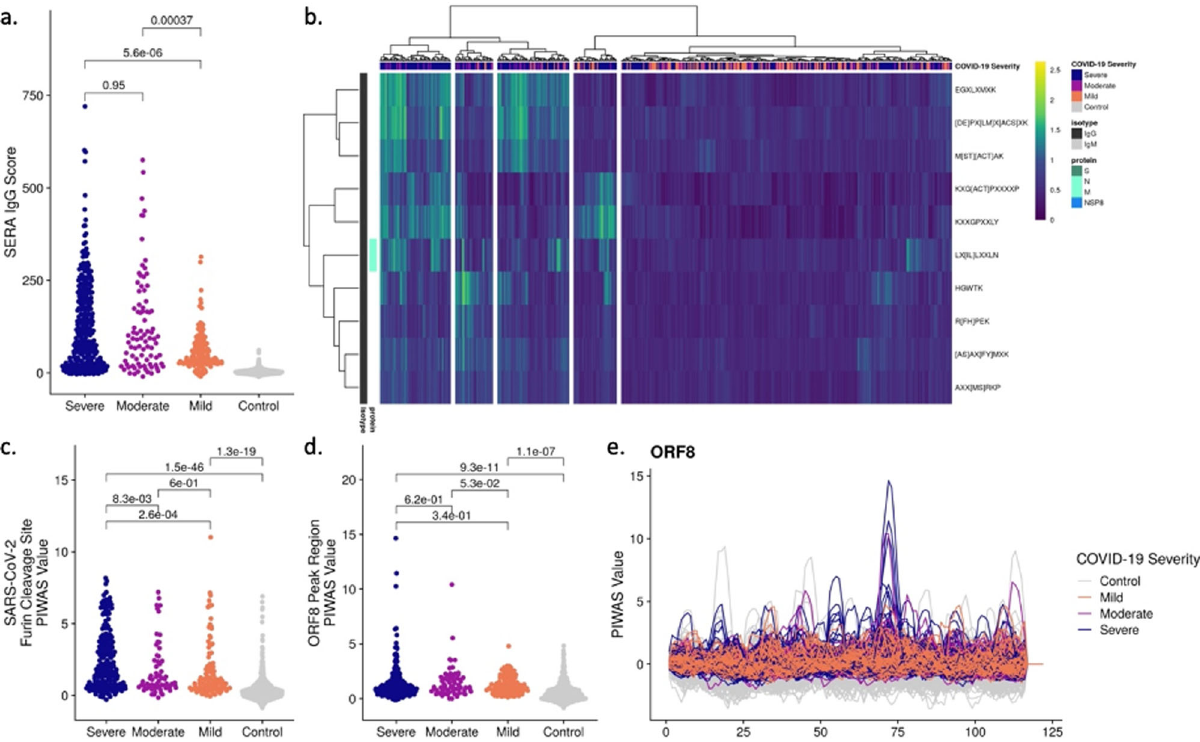
Fig. 4 Signi fi cantly different epitope signals are observed in mild, moderate, and severe cases of COVID-19. a Comparison of SERA total IgG motif panel scores for severe ( n = 447), moderate ( n = 134), and mild ( n = 170) cases based on motifs used in the diagnostic panel (Fig. 3). Colors indicate disease severity. b Severe, moderate, and mild cases of SARS-CoV-2 are clustered based on log-enrichment of the top 10 motifs identi fi ed by a t-test comparison of severe and mild patients. c Distribution of PIWAS values at SARS-CoV-2 furin cleavage site for severe, moderate, and mild cases. d Distribution of PIWAS values for the peak epitope in ORF8 for severe, moderate, and mild cases. e PIWAS tiling of individual samples on the entire ORF8 sequence. All p-values were calculated using outlier sum statistical